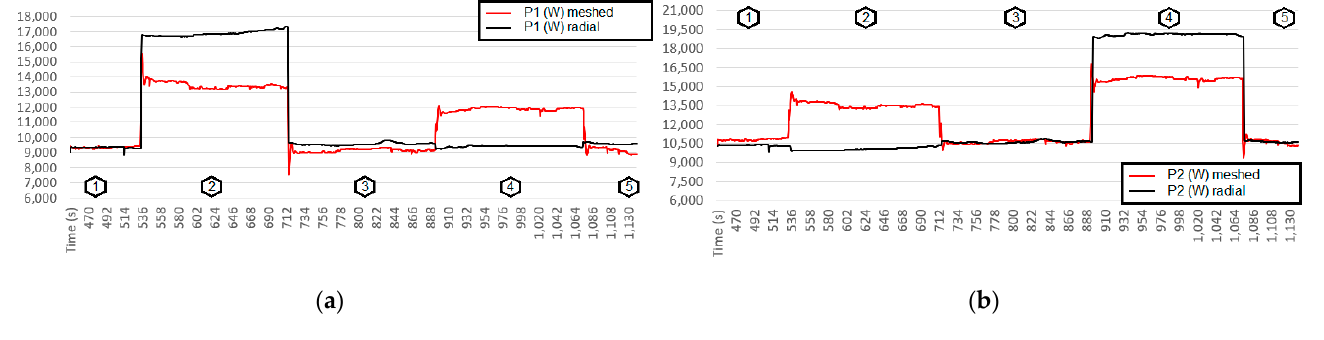
Figure 15. Active power delivered by each feeder; ( a ) P provided from feeder A; ( b ) P provided from feeder B.